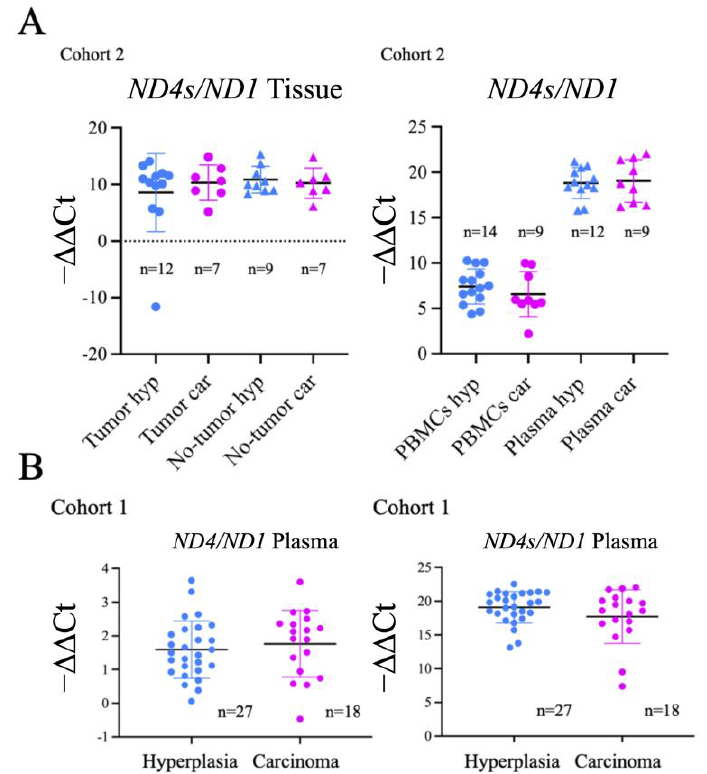
Figure A3. No significant differences in ND4 s/ ND1 ratios between thyroid carcinoma and hyperplasia samples. ND4 s/ ND1 ratio was evaluated in plasma, tissue and PBMCs. ( A ) Cohort 2. ( B ) Cohort 1. Data are mean ± standard deviation (SD).